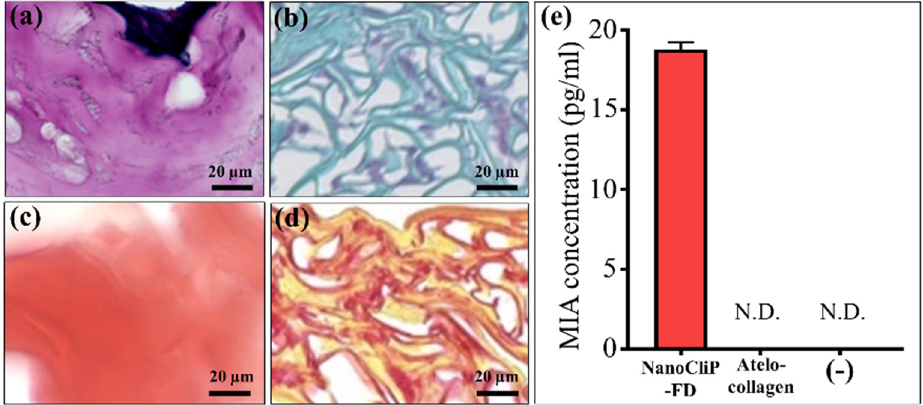
Figure 2. Light microscopy images of Safranin O staining in chondrogenic medium (( a , b ) for NanoCliP-FD gel and atelocollagen, respectively) and of Picrosirius red staining (( c , d ) for NanoCliP-FD gel and atelocollagen, respectively). In ( e ), the results of MIA concentrations in culture supernatant at 14 days culture are compared between NanoCliP-FD gel and atelocollagen scaffolds. The (-) symbol represents the negative control (no scaffold).